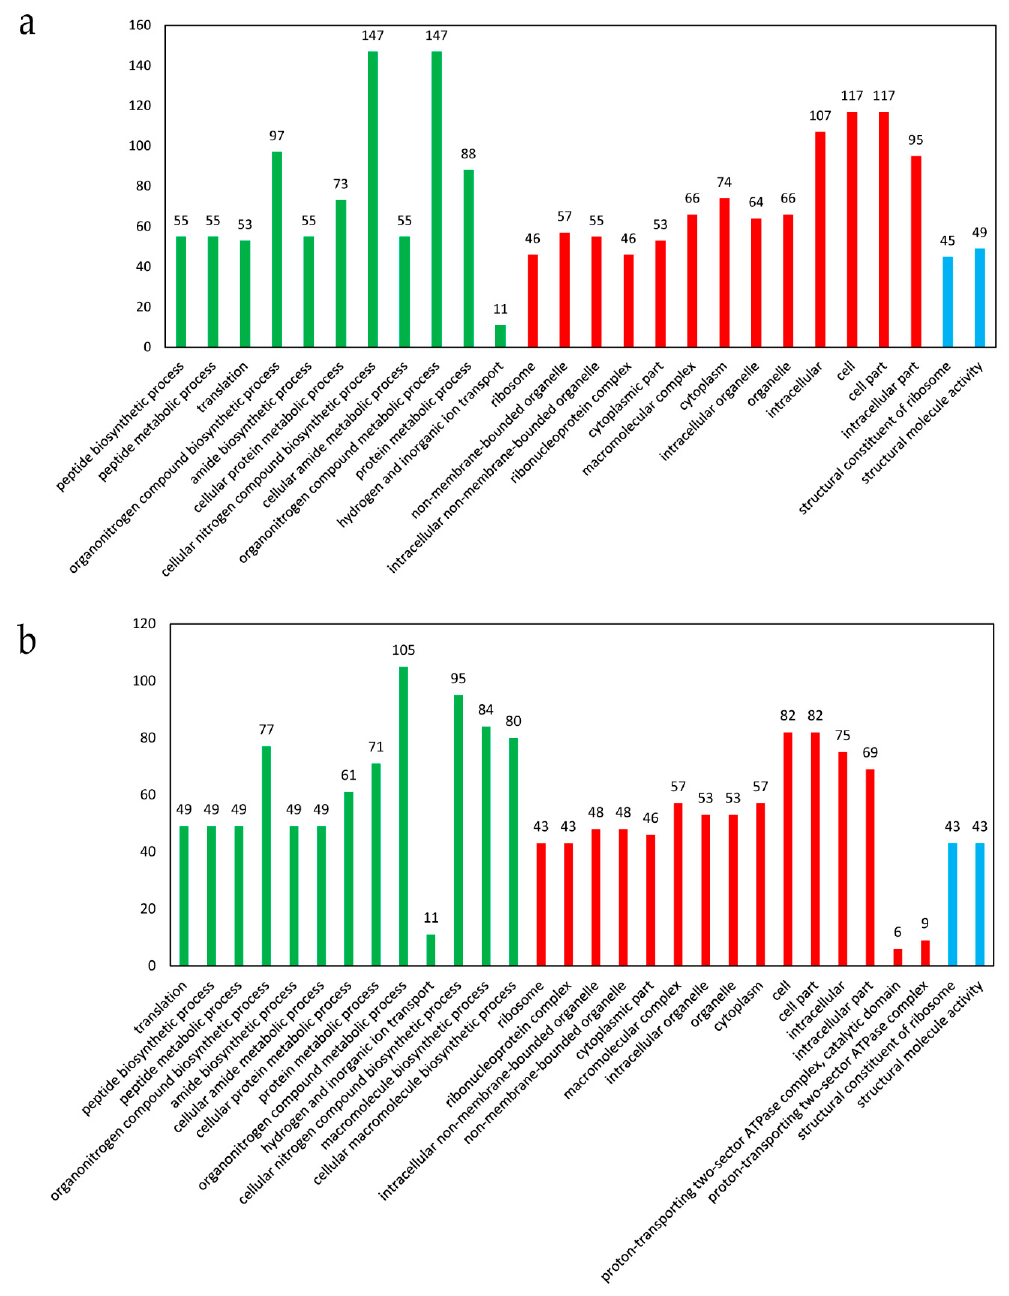
Figure 4. The significantly enriched GO terms of the DEGs in response to ferrous iron toxicity. ( a ) Analysis of all the DEGs. All the significantly enriched GO terms are shown. ( b ) Analysis of the up-regulated genes. The top 30 significantly enriched GO terms are shown. The X -axis indicates the enriched GO terms, and the Y -axis indicates the number of the DEGs for each GO term. The GO terms in green color belonged to biological processes, those in red belonged to cellular components, and those in blue belonged to molecular function. The GO enrichment analysis was performed using the GOseq method with Wallenius non-central hyper-geometric distribution. The GO terms with a corrected p -value < 0.05 were considered to be significantly enriched.